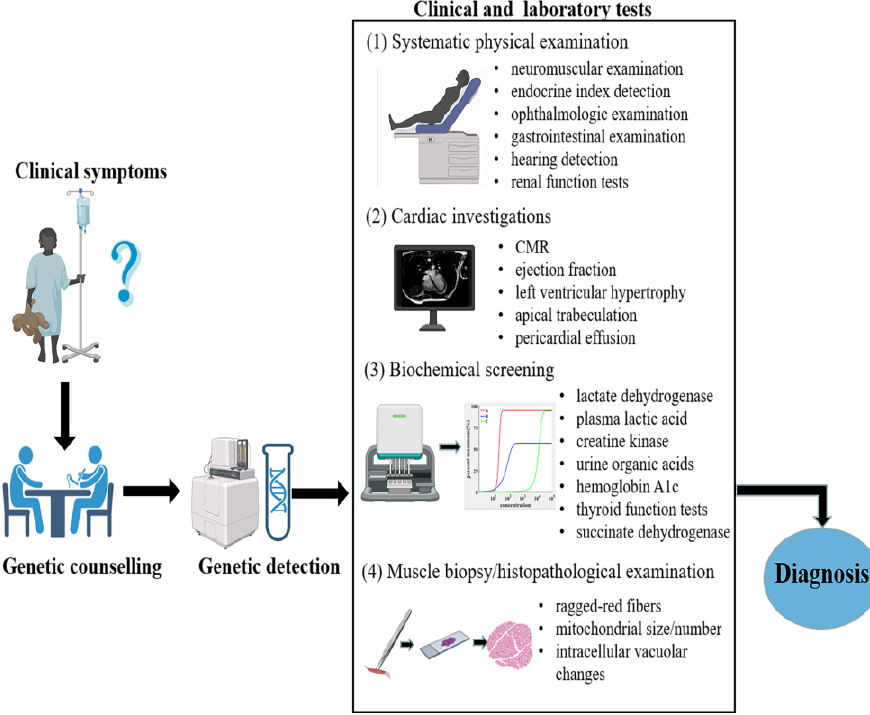
Figure 2. Flow chart for diagnosis of mitochondrial diseases.